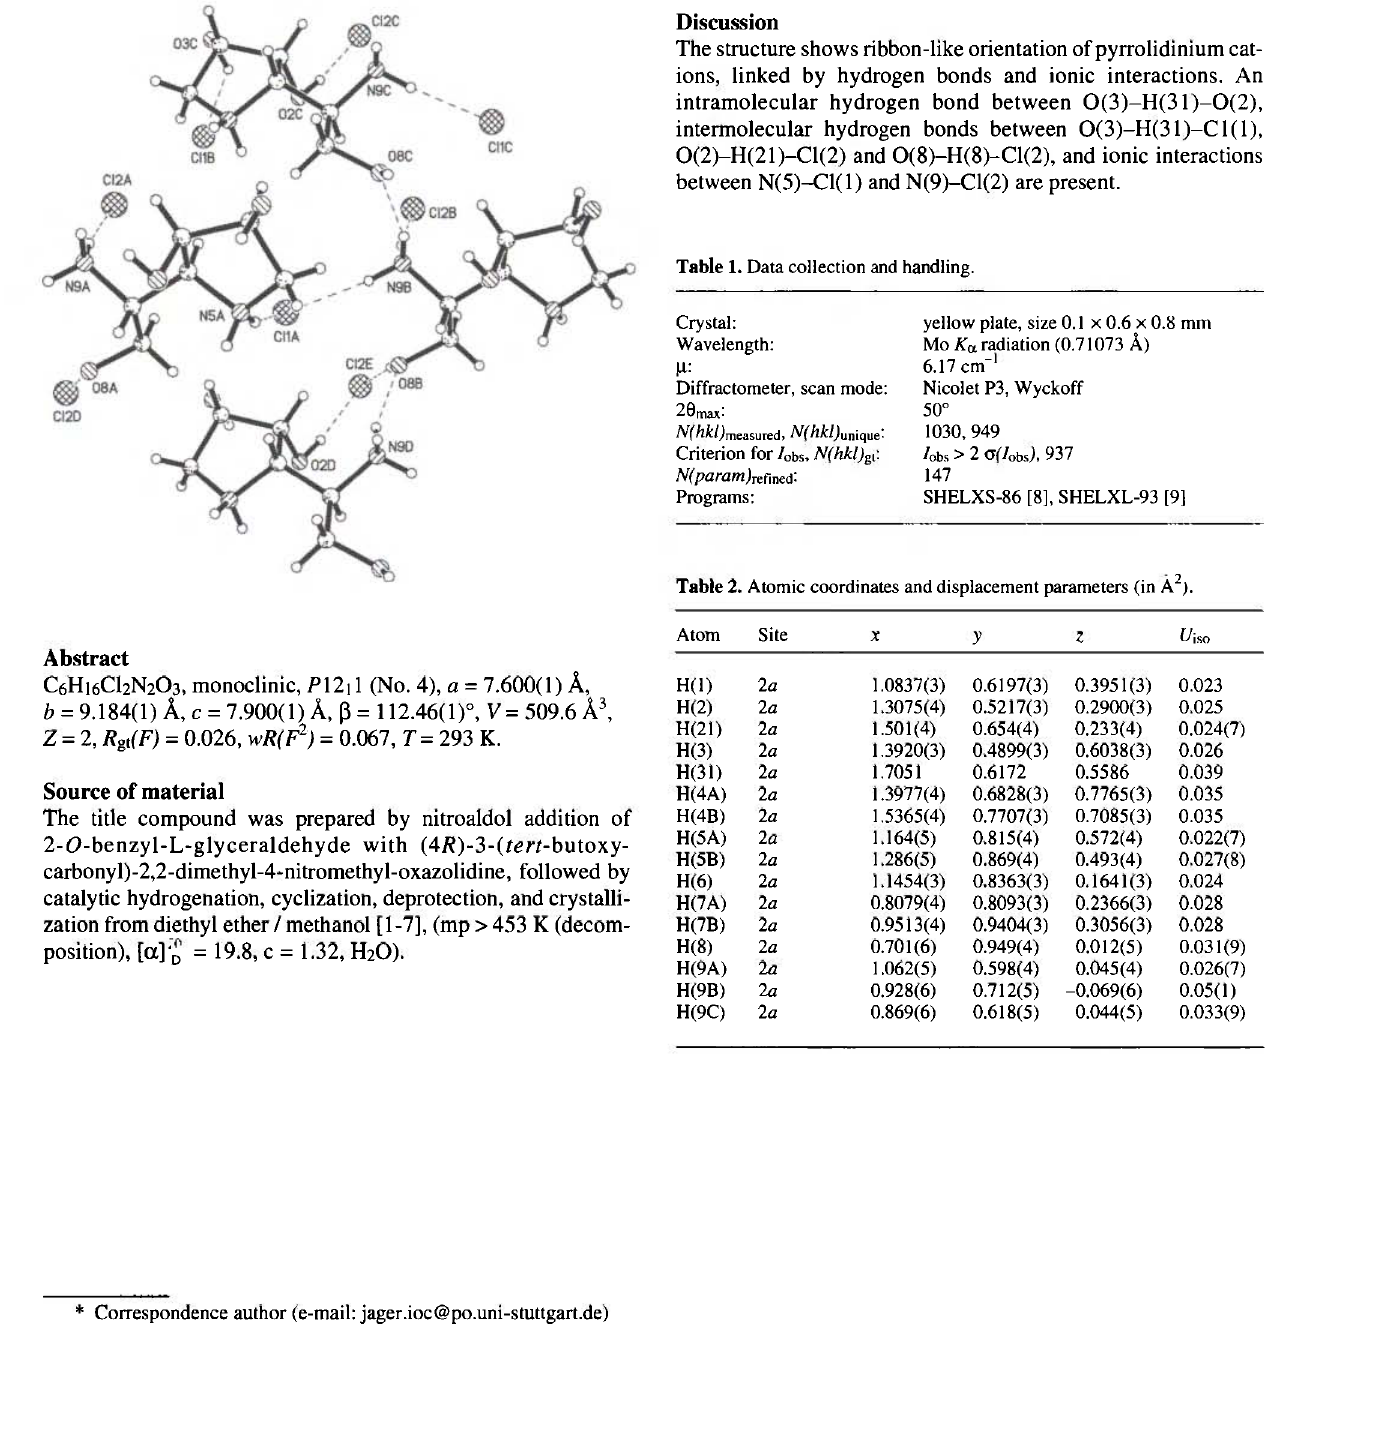
Table 1. Data collection and handling.